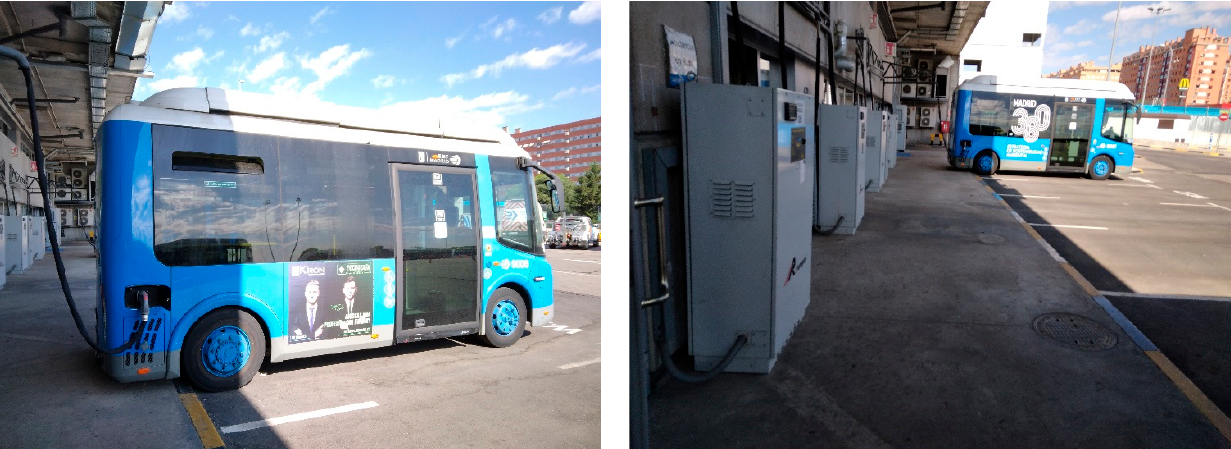
Figure 5 . Pictures of wired charging for minibuses in Carabanchel OC (Madrid). Figure 5. Pictures of wired charging for minibuses in Carabanchel OC